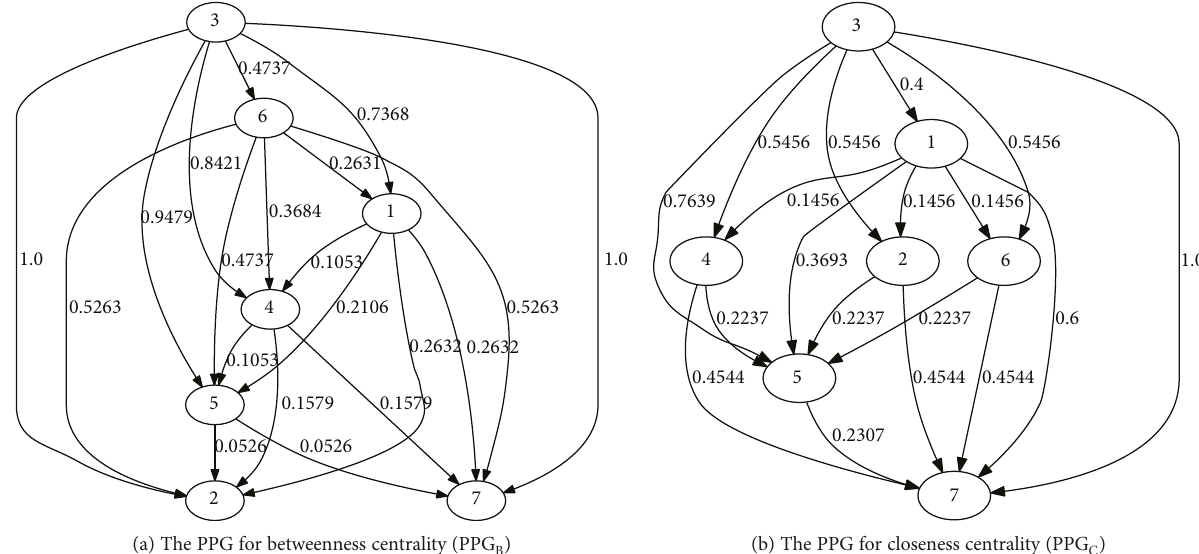
Figure 4: The PPGs w.r.t. other two measures for the example network.